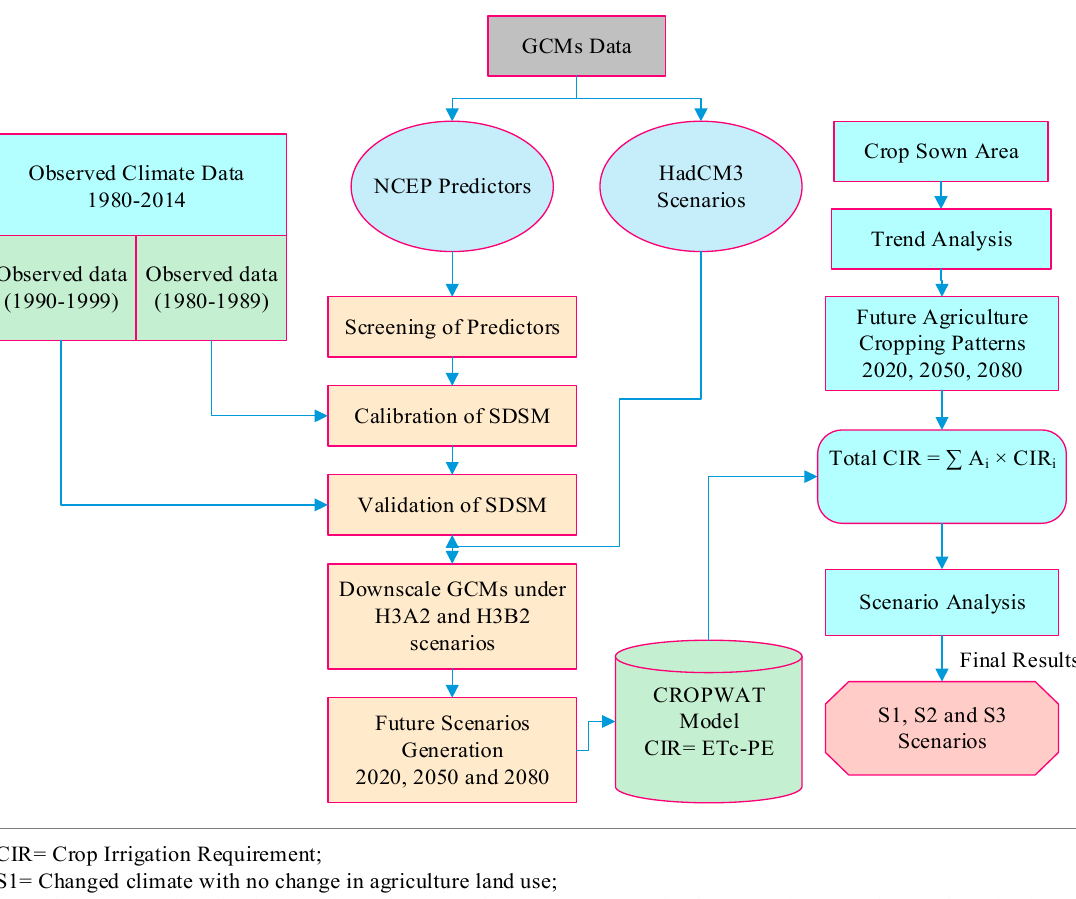
Figure 3. Stepwise procedure of computing crop irrigation requirement (CIR) using observe climate data, General Circulation Models (GCMs), and crop information data.